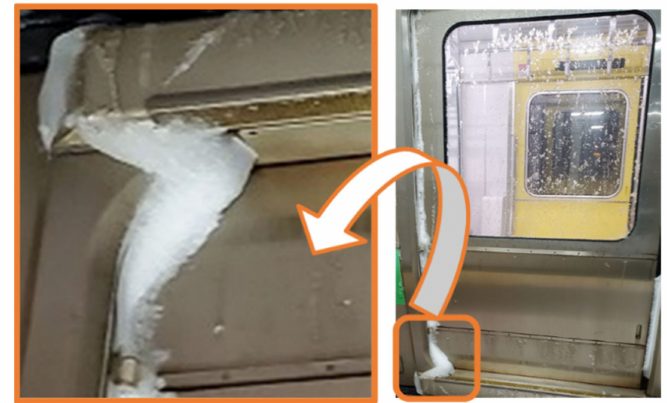
Figure 17. Snow deposition on actual train